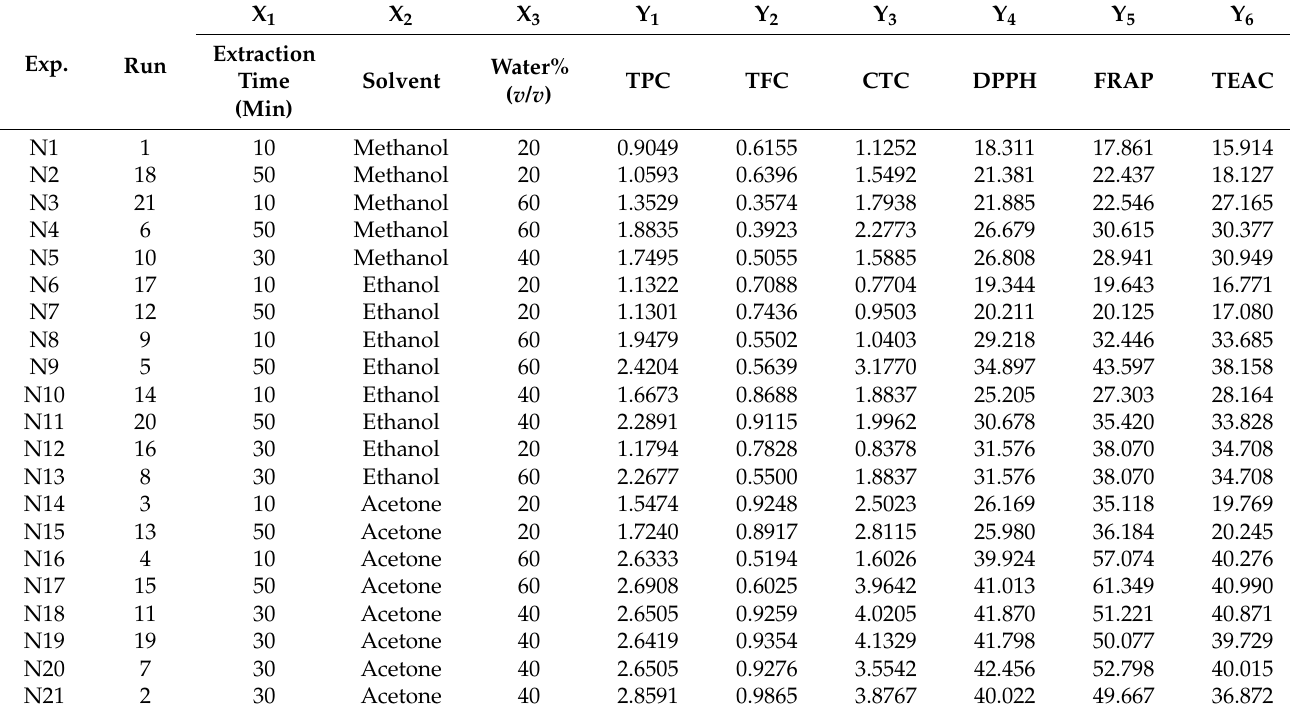
Table 2. Matrix of experimental design and experimental results of walnut flower extracts based on a factorial design.